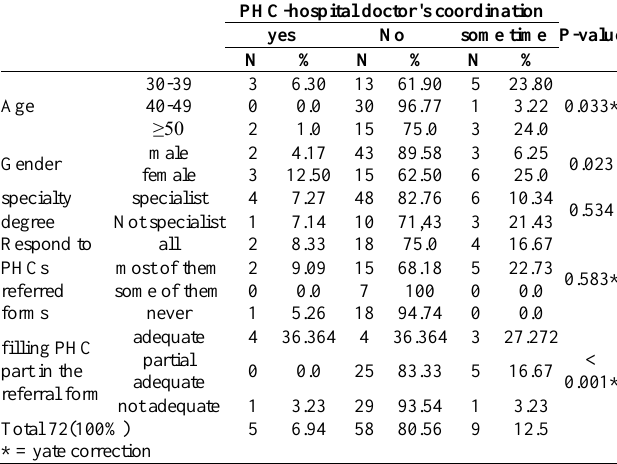
Figure 2: Distribution of Doctors Suggestion About the Referral System Table 3: Association between PHC-hospital doctor's coordination and the doctors' characteristics: